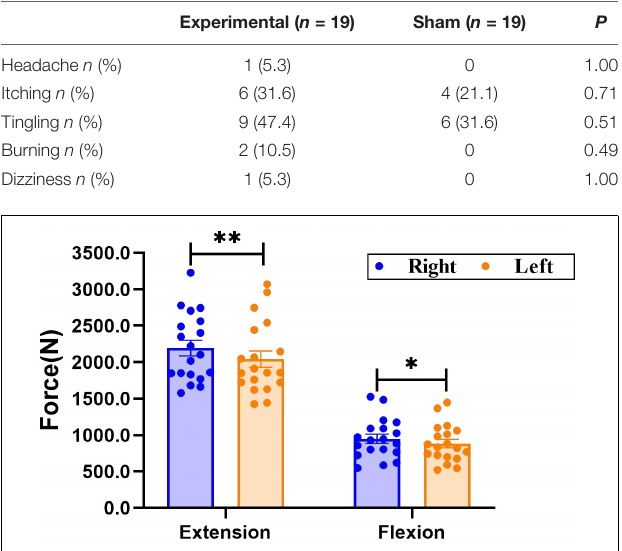
FIGURE 2 | Comparison of bilateral knee extensor and flexor strength. Data are presented as mean ± SEM. Asterisks ( ∗ ) indicate statistically significant difference ( ∗ P < 0.05, ∗∗ P <